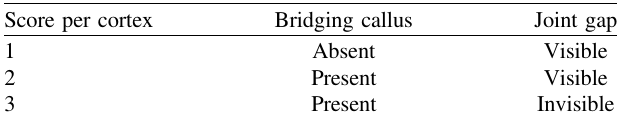
Figure 3. Excised osteophytes from distal tibia and talar neck before morselization. Table 1. Scoring criteria for modi fi ed